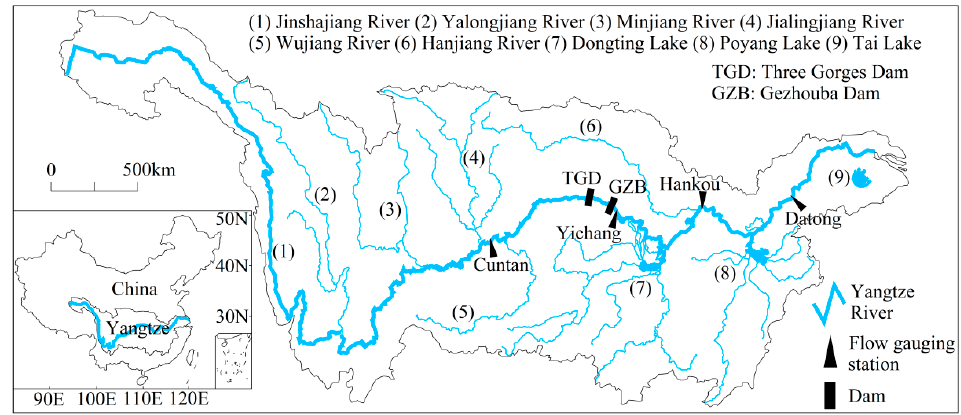
Figure 1. Locations of the Yangtze River and the flow gauging stations.